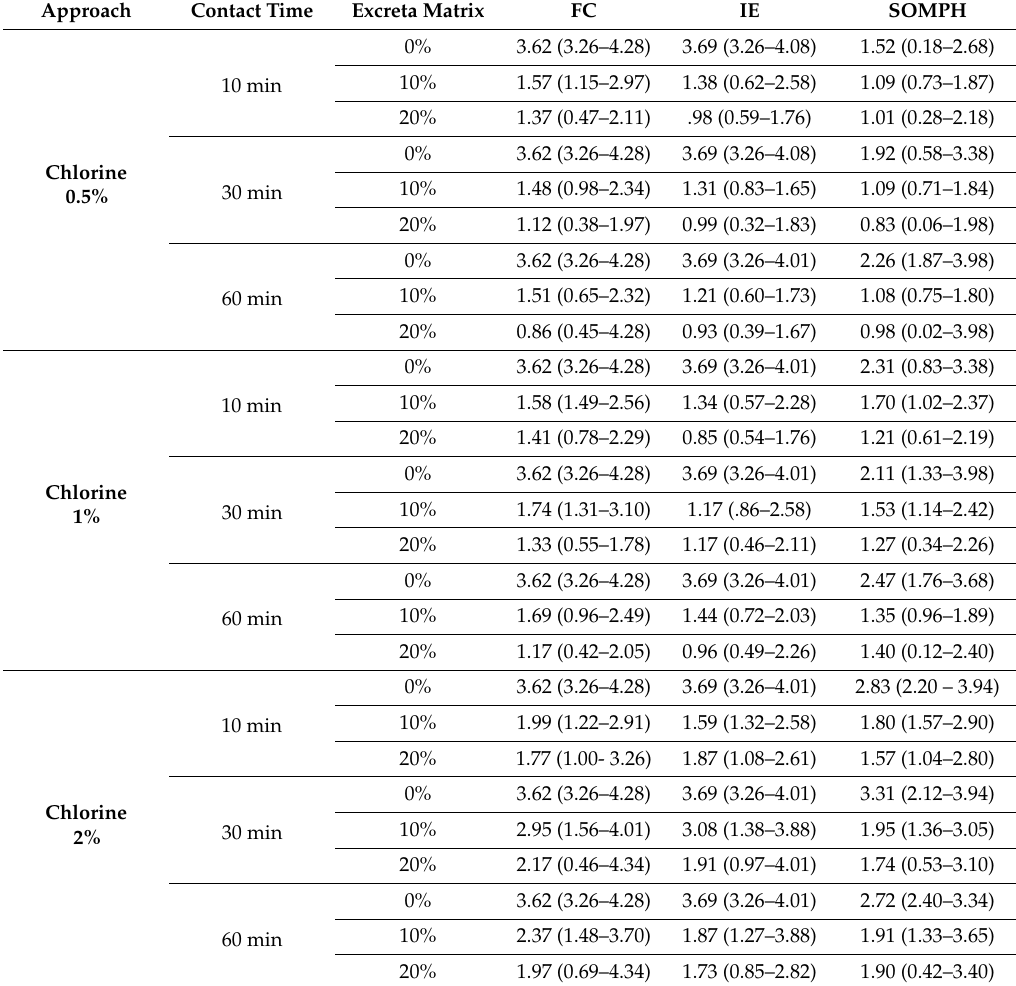
Table 1. Summary of median (range) log reduction of all microorganism (faecal coliforms (FC), intestinal enterococci (IE) and somatic coliphages (SOMPH)) according to approach, contact time, and excreta